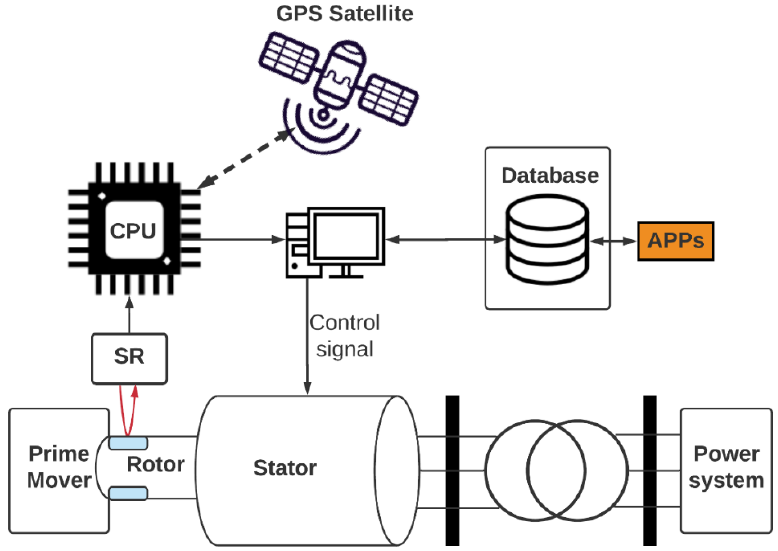
Figure 3. The synchronized angular velocity measurement system.